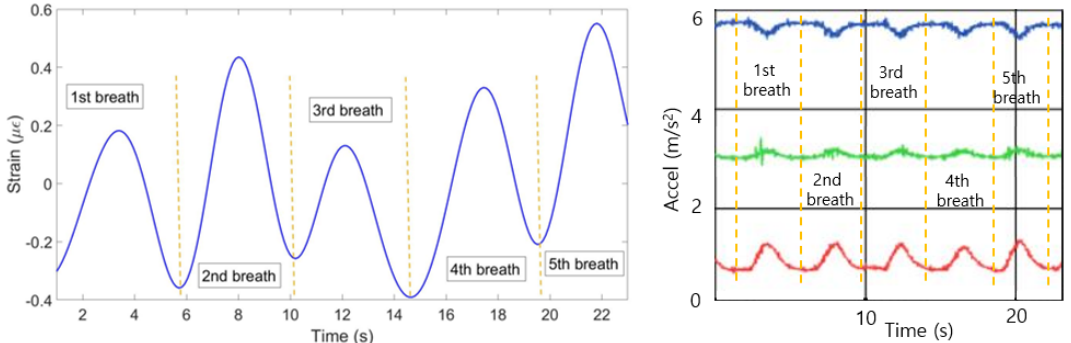
Figure 18. Breathing pattern for the first volunteer in the lying position detected by: FBGs on the chest ( left ) and abdomen regions ( right ).